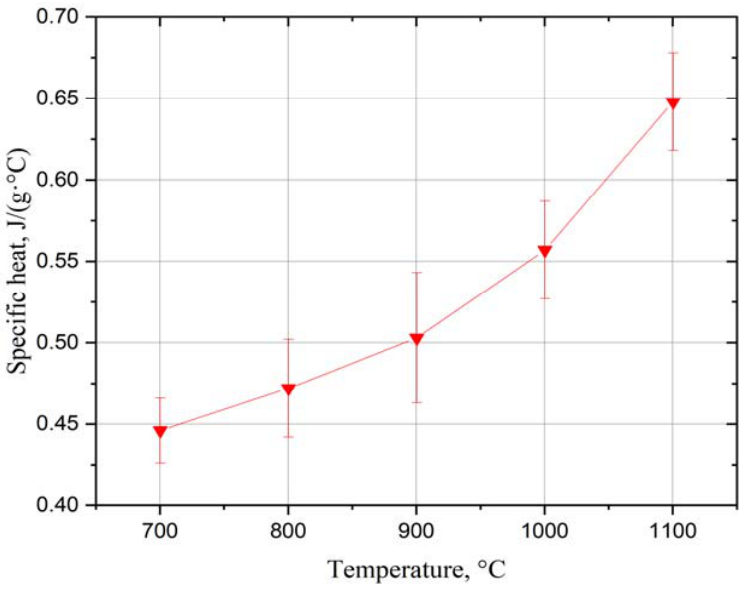
Figure 4. Specific heat of the Yb 2 Zr 2 O 7 coating in temperature range 700–1100 °C. The thermal diffusivity of the ytterbium zirconate coating rises with increasing temperature from 0.11–0.14 mm 2 /s at 700 °C to 0.14–0.2 at 1100 °C (Figure 5). The highest thermal diffusivity was measured for the coating obtained using the power current 2200 A.